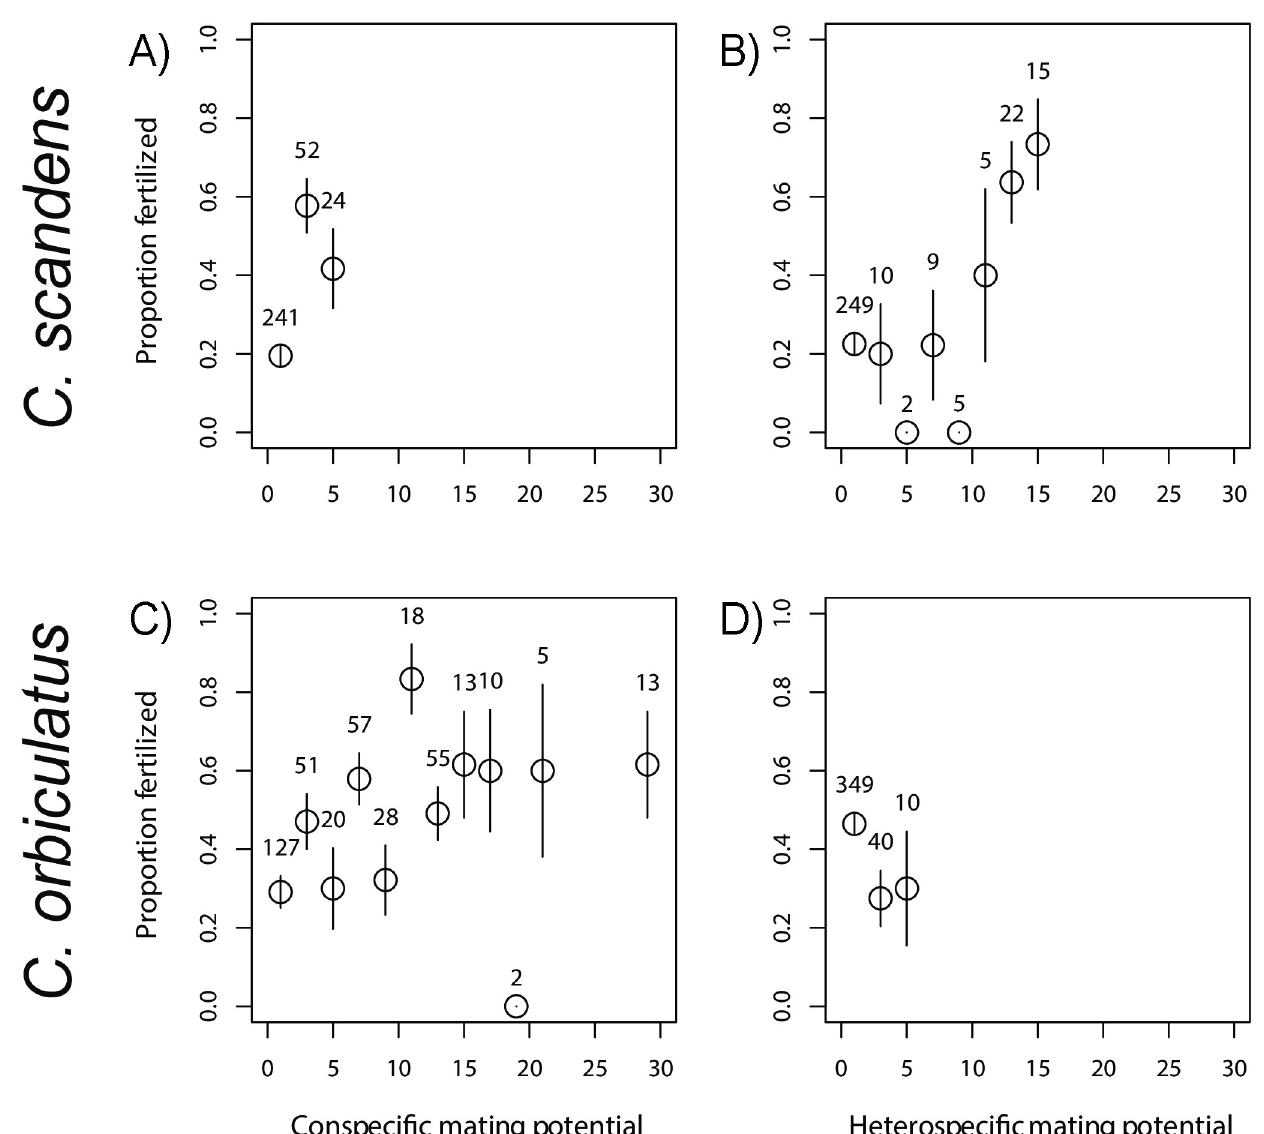
Fig 3. Fertilization rate and conspecific or heterospecific mating potential. Results from 317 individually marked C . scandens (A, B) and 399 individually marked C . orbiculatus (C, D) flowers are shown. Numbers above the symbols represent the number of flowers included in each binned category. In C . scandens , fertilization rate was statistically associated with conspecific mating potential (A; Table 3) and heterospecific mating potential (B; Table 3). In C . orbiculatus , fertilization rate was only associated with conspecific mating potential (C: Table 4). See Eq 1 for the calculation of mating potentials. Error bars represent the standard error.